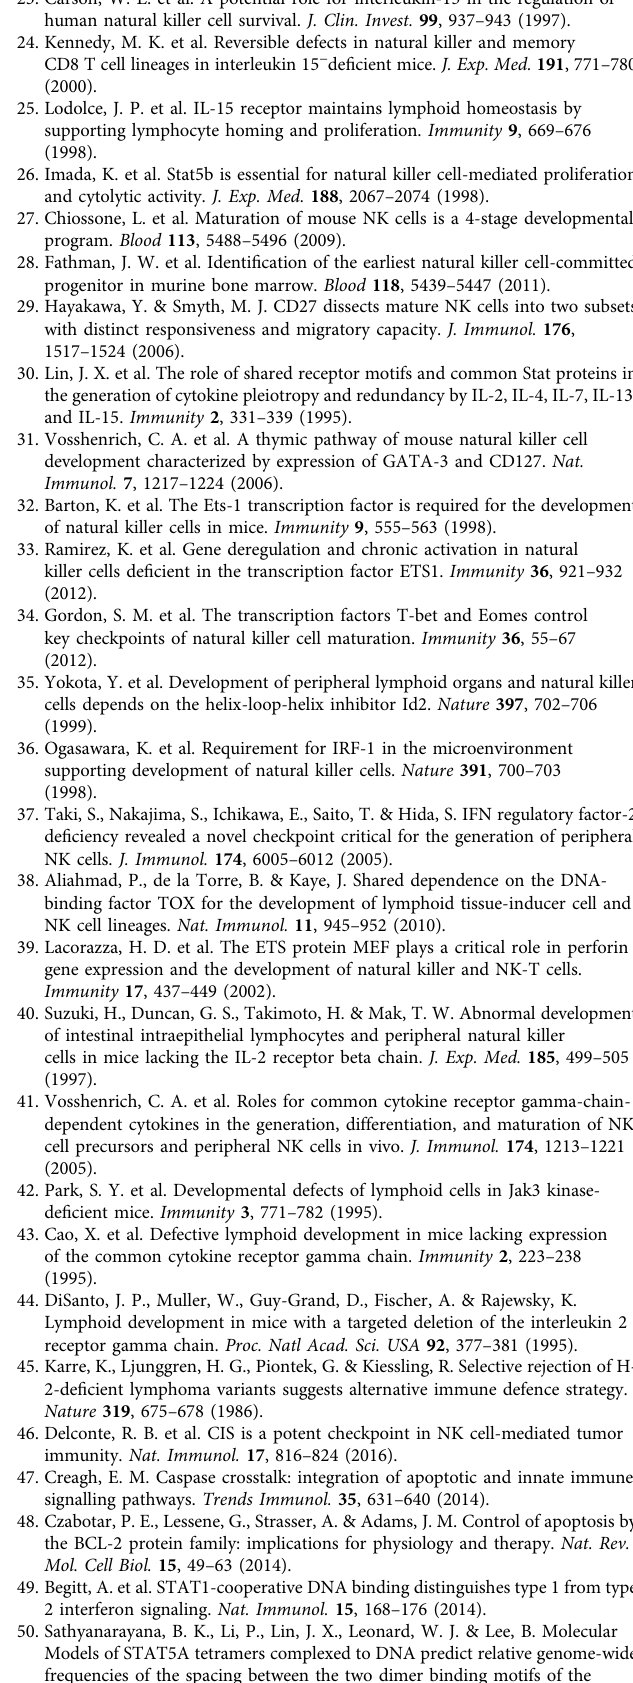
Statistical analysis . Statistical analyses were performed by grouped multiple t -test analysis using Prism 7.0b (GraphPad Software, Inc., La Jolla, CA), error bars are means ± SEM; **** p < 0.0001; *** p < 0.001, ** p < 0.01; * p < 0.05; NS, p >